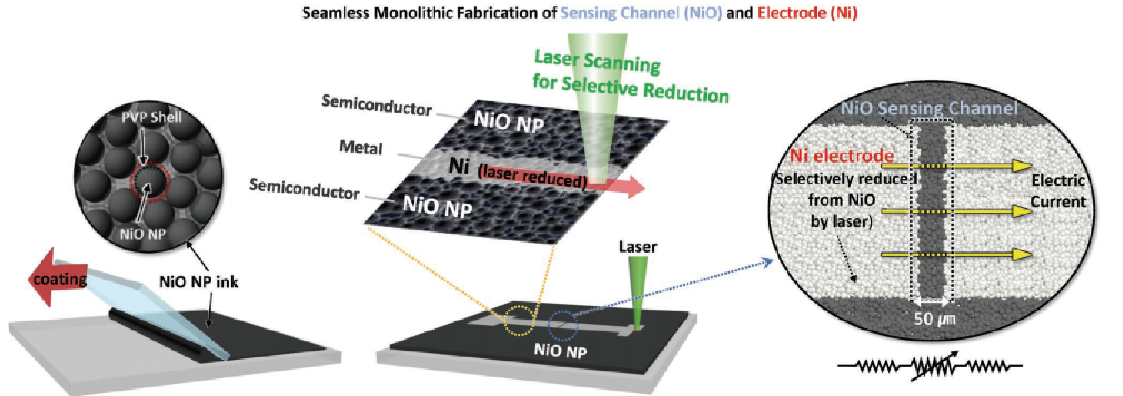
Figure 4. Schematic of the monolithic laser reductive sintering process. NiO nanoparticle ink is coated on a substrate by the doctor blading technique. The selective laser irradiation of the dried NiO layer using a computer-aided galvano-mirror system and the monolithic Ni–NiO–Ni structure, having several tens of micrometer-wide NiO-channels, was formed by the simple hatching technique. Reprinted with permission from Ref. [46]. Copyright 2020 Wiley-VCH.